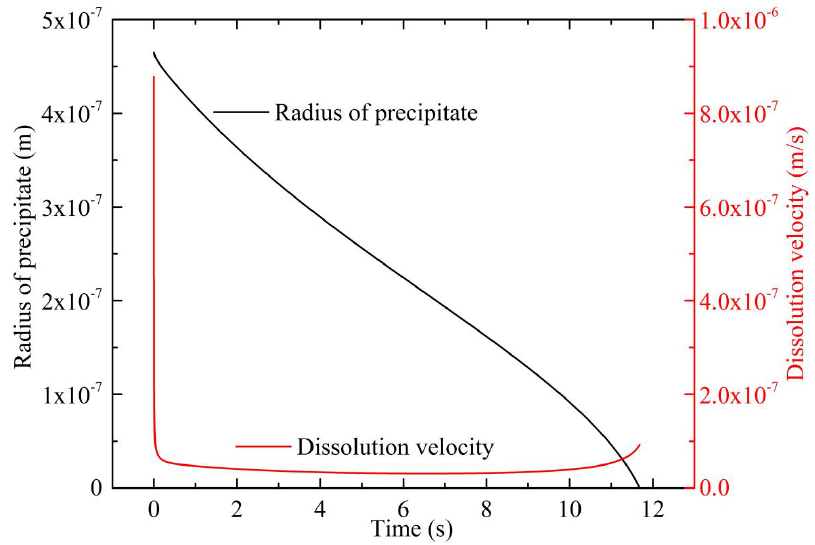
Figure 7. Radius of the precipitate and dissolution velocity vs. time during dissolution.